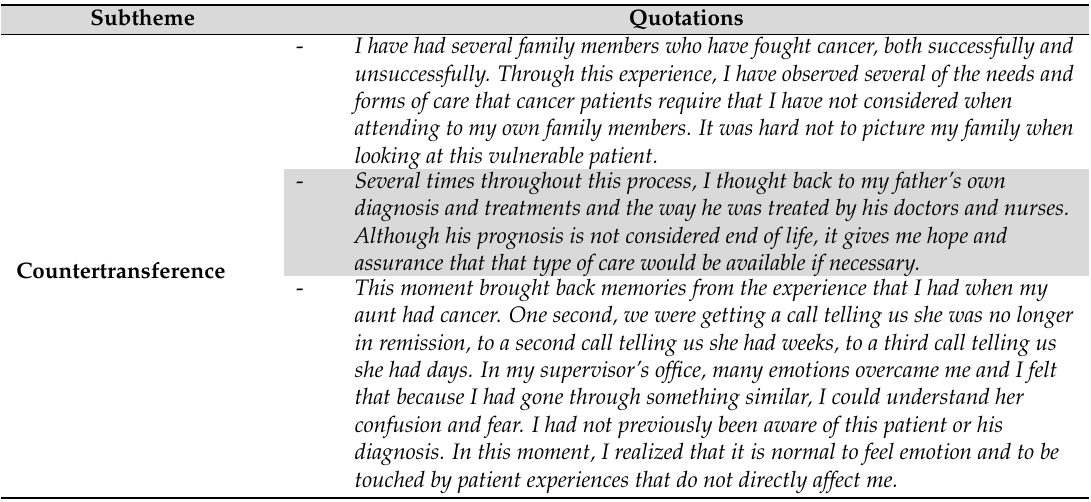
Table 9. Quotes related to the subtheme of countertransference.